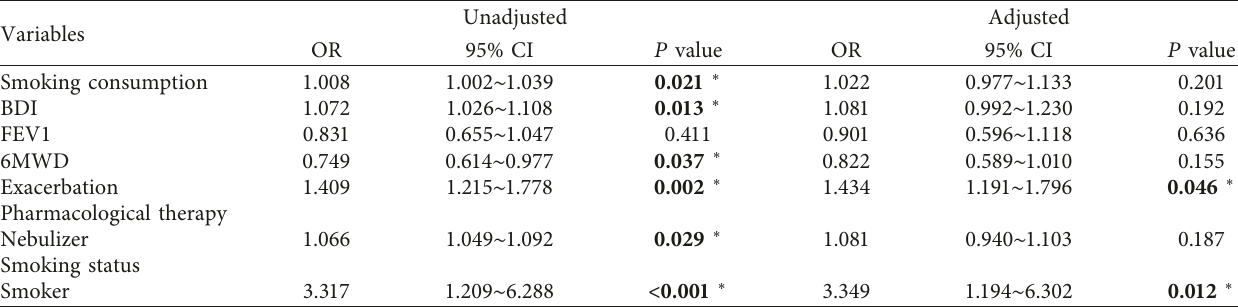
Table 3: Univariate and multivariate analyses of independent factors of nonadherence of home-based PR. Variables